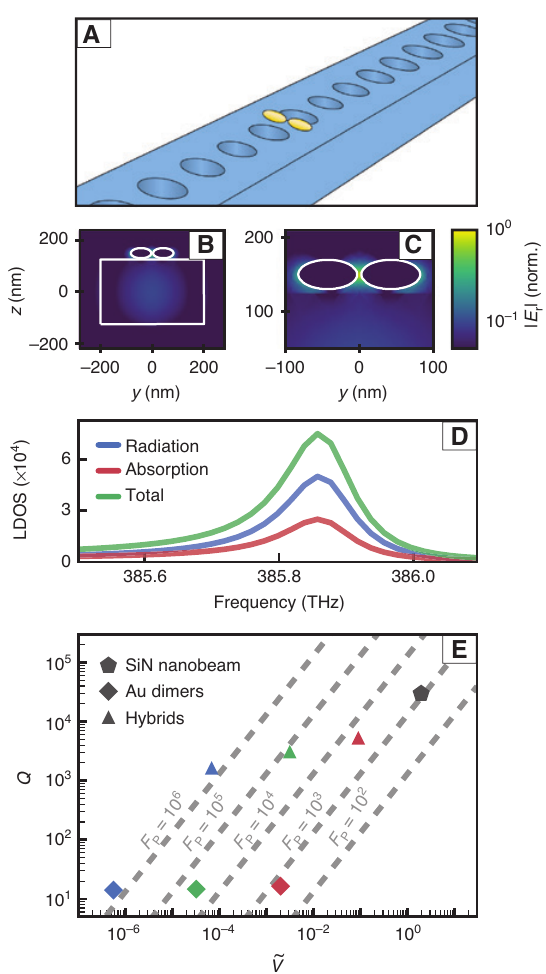
Figure 3: Properties of the hybrid system calculated with numerical